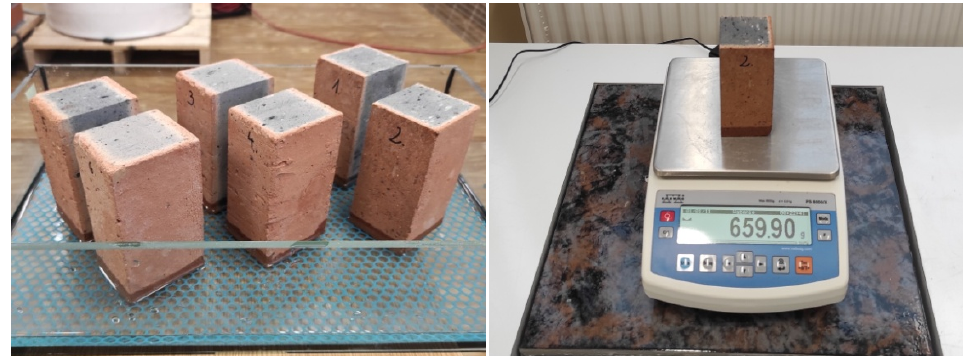
Figure 2. Examples of Group A and B samples prepared for testing.